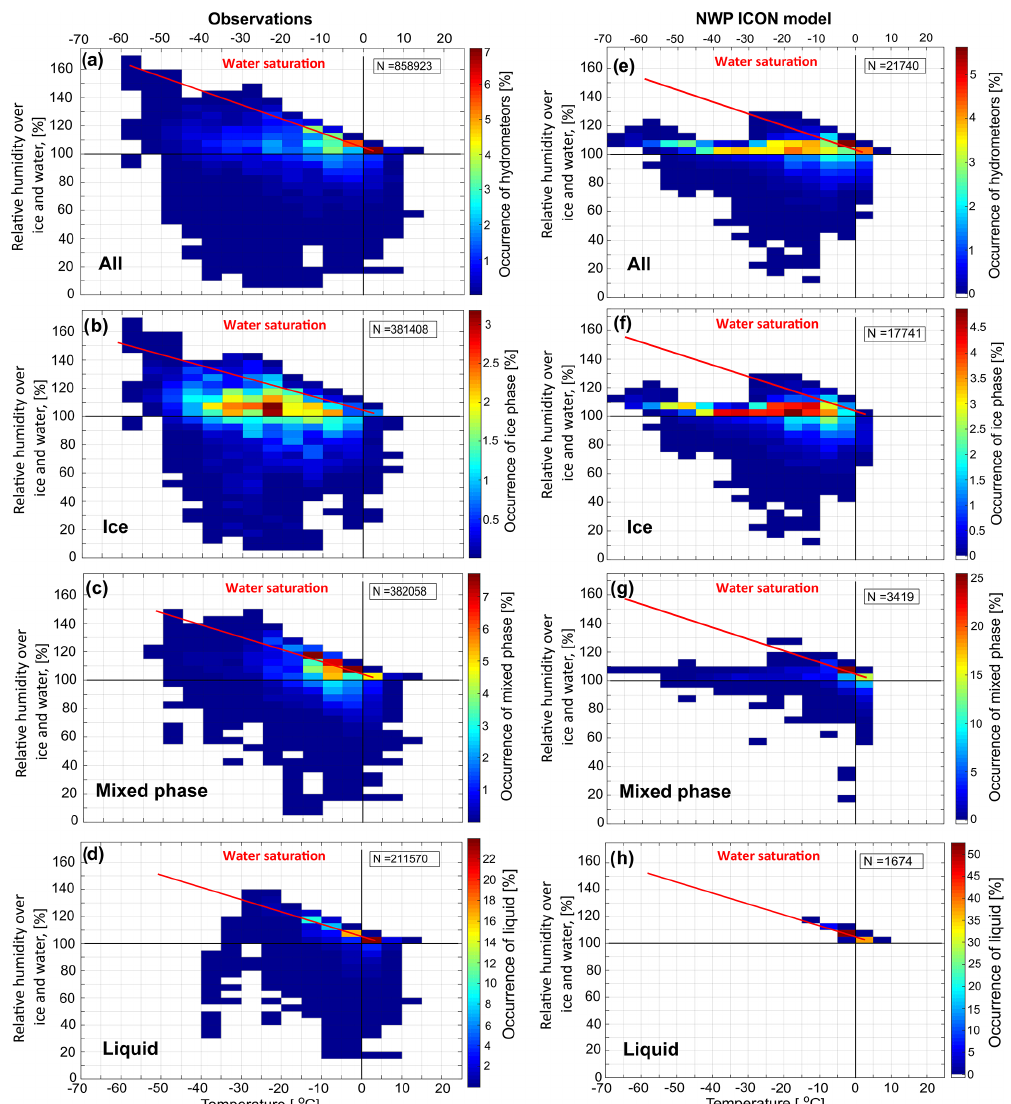
Figure 13. Two-dimensional histograms of in-cloud atmospheric temperature and relative humidity for all clouds (a, e) , ice clouds (b, f) , and mixed-phase clouds (c, g) . For (a, c, e, g) ice and/or liquid phases are present. For (b) and (f) only the ice phase is present. The liquid phase of liquid-containing clouds is shown in (d) and (h) . Only cases of single-layer clouds are included and shown for observations (a–d) and for column output of the NWP model ICON over Ny-Ålesund (e–h) . Frequency of occurrence is normalized by the total number of bins of the correspondent single-layer clouds detected between the period of 1h before and after radiosonde